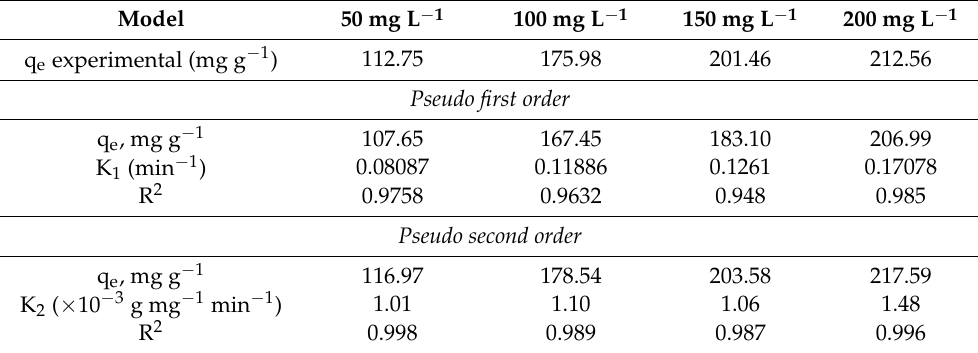
Figure 7. MB uptakes on RF/TiO 2 gel at ( a ) 50 mg L − 1 , ( b ) 100 mg L − 1 , ( c ) 150 mg L − 1 , ( d ) 200 mg L − 1 , and fitted data for pseudo first order and pseudo second order kinetic models. Table 1. Kinetic parameters obtained by fitting kinetic data for MB adsorption to RF/TiO 2